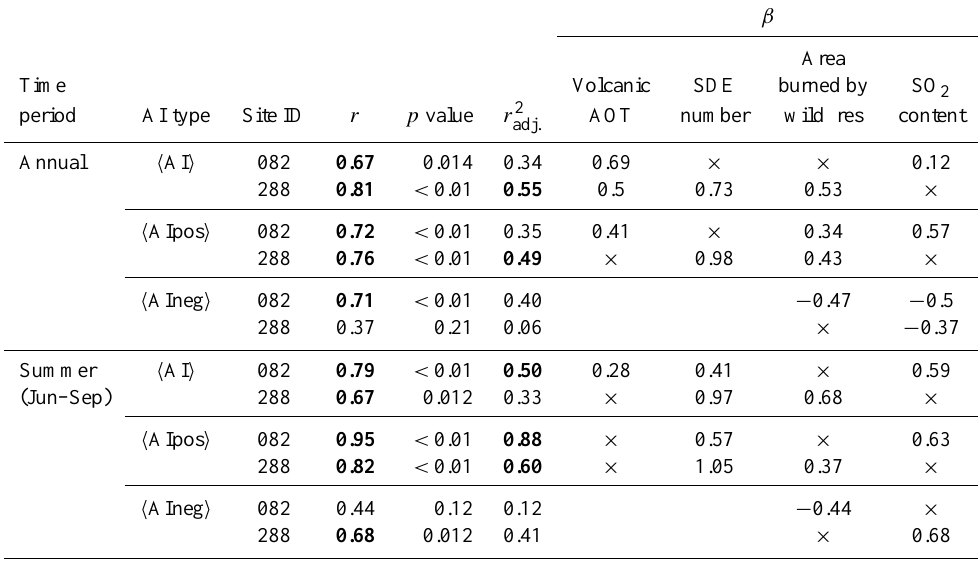
Table 2. Parameters of multiple regression models of AI annual and summer series (see Sect. 3.2 for parameter descriptions). The correlation coefficients r greater than 0.67 and r 2 equal or greater than 0.45 are in bold, and “ × ” marks the parameters that were excluded from a adj. particular “best